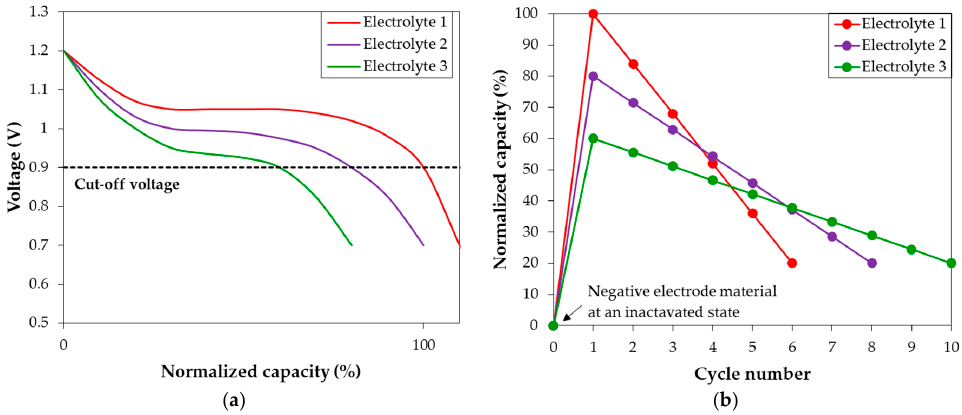
Figure 10. Schematics of ( a ) the first cycle discharge voltage profiles and ( b ) capacity cycle data from three hypothetical electrolytes with different activation powers (Electrolyte 3 < Electrolyte 2 < Electrolyte